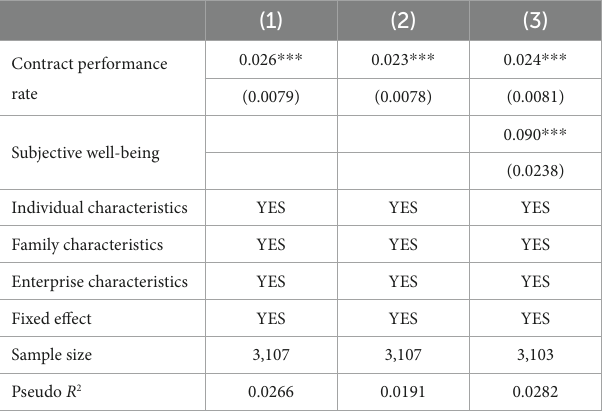
TABLE 5 Regression results of the mediating effect using the oprobit model.